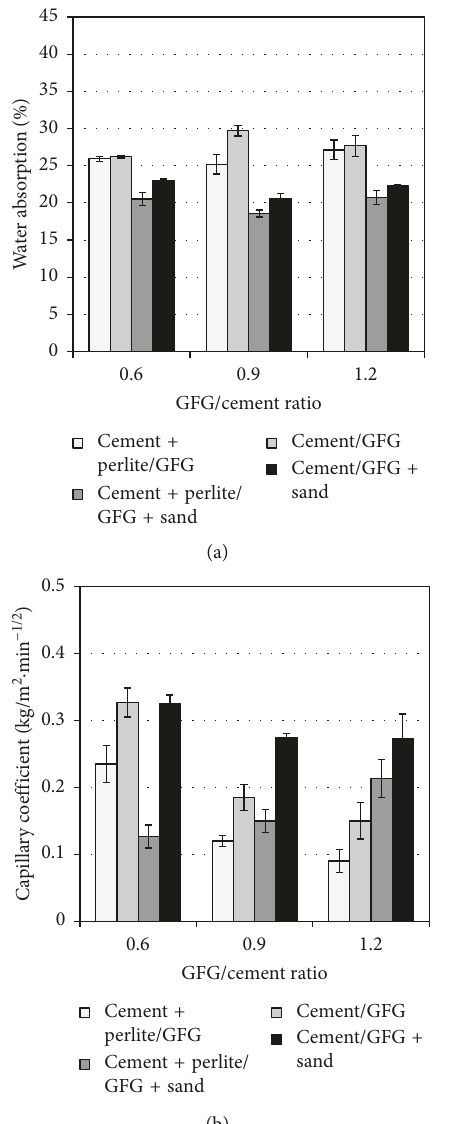
F IGURE 11: Water sorption of